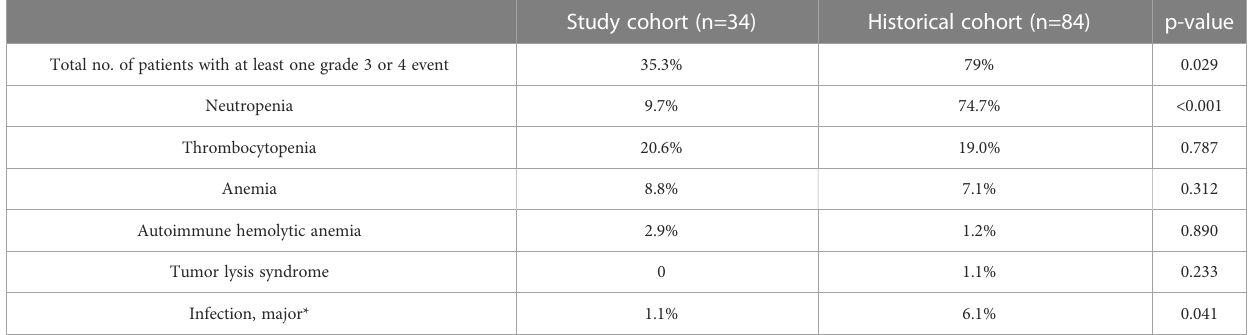
TABLE 4 Incidence of grade 3 and 4 adverse